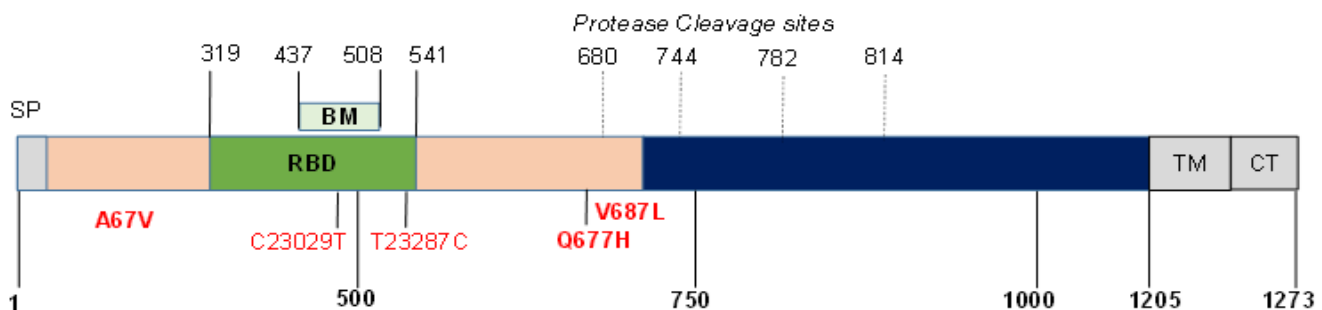
Figure 1. Position map of S-protein mutations in SARS CoV-2. The position of rare amino acid mutations and the single nucleotide exchanges in the NC_045512 Wuhan-Hu-1 genome sequence identified in this study are highlighted in red. The GSAID accession numbers are listed in Table 2.